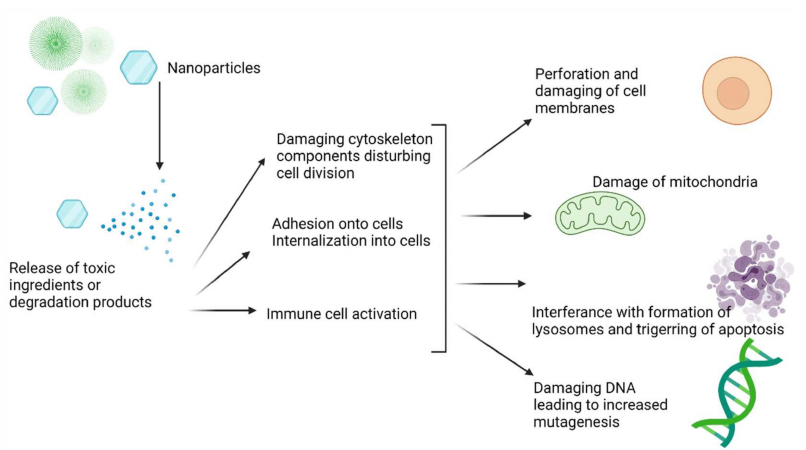
Figure 4. The most common mechanisms causing toxicity associated with nanotechnology [66–68] (Figure created with BioRender.com (accessed on 25 April